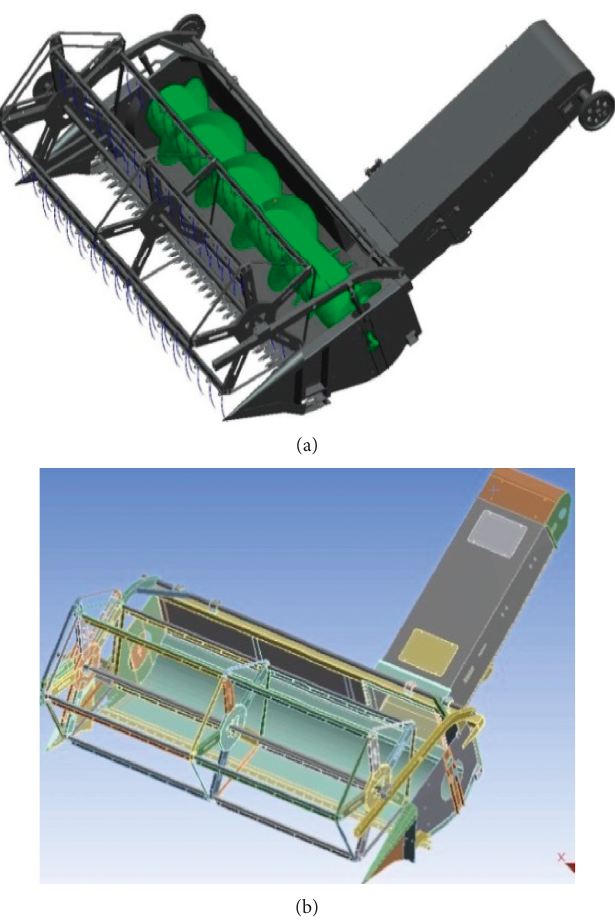
Figure 10: Assembly device model of the front header. (a) 3D model in Pro/E. (b) Import mode in ANSYS.